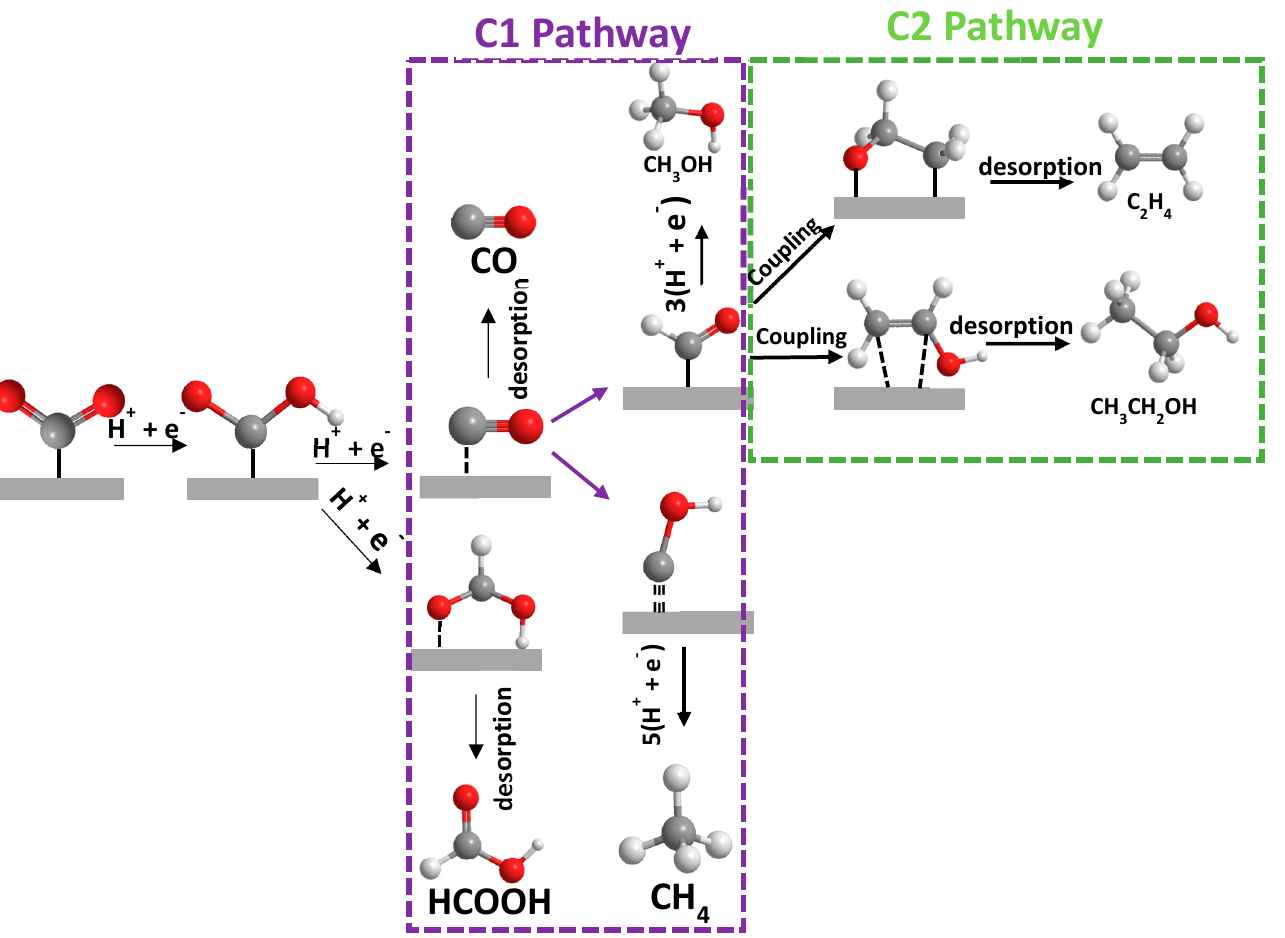
Figure 2. Scheme showing some possible pathways for the CO 2 reduction to C1 and C2 products.